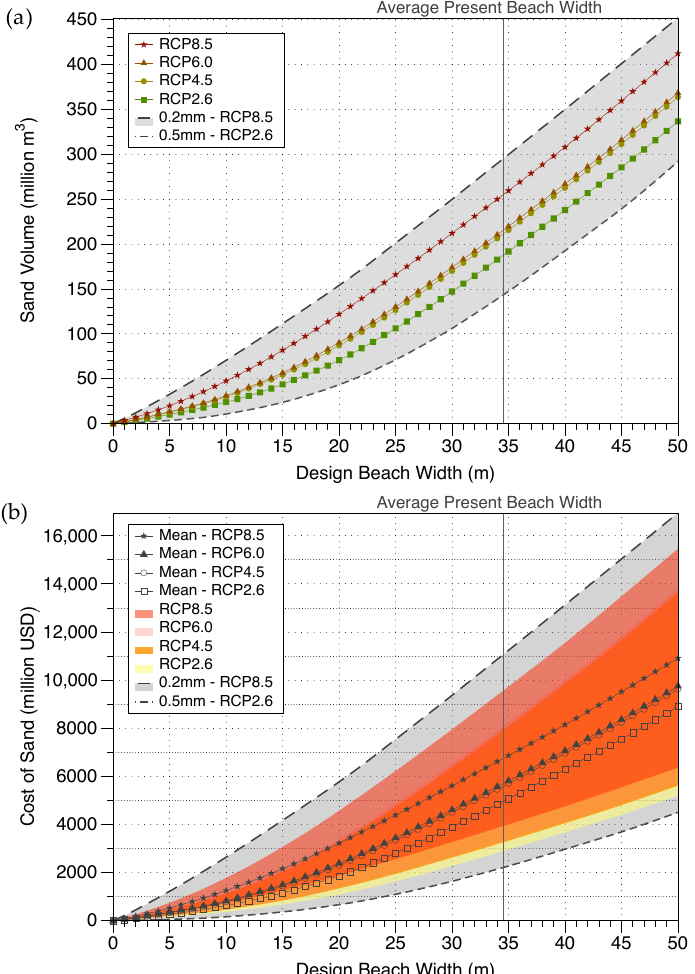
Figure 6. Volume and costs of sand for beach nourishment to combat SLR in each RCP scenarios. ( a ) The total volume of sand for each designed beach width for entire sandy beach in Thailand; ( b ) the summation of costs for beach nourishment. ( a ) The calculations of the colored lines for each RCP scenario were based on the same size for filling particle and native particle. The upper and lower bounds of grey-shaded area were calculated based on particle sizes of 0.2 and 0.5 mm. ( b ) The sand volumes were multiplied by the maximum unit cost of USD 37.5 / m 3 and the minimum unit cost of USD 15.5 / m 3 of sand, respectively. The warm color-shaded areas represent cost ranges (minimum to maximum) with lines representing the mean costs for each RCP